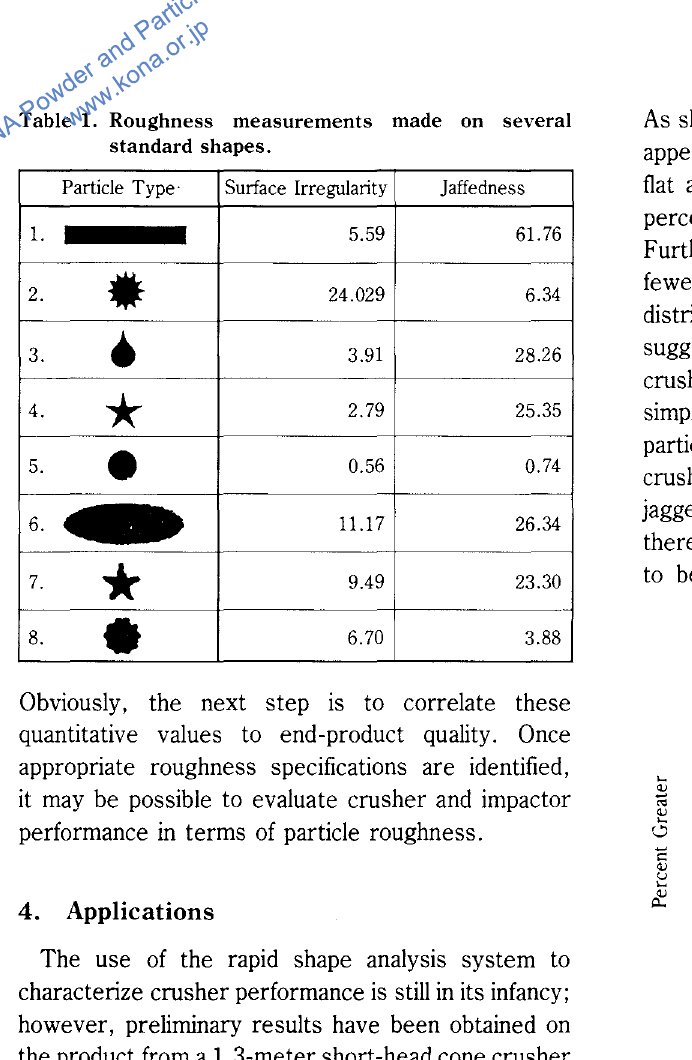
Fig. 7 Comparison of the elongation distributions as a function of particle size obtained from the product of a 1.3-meter short-head cone crusher.